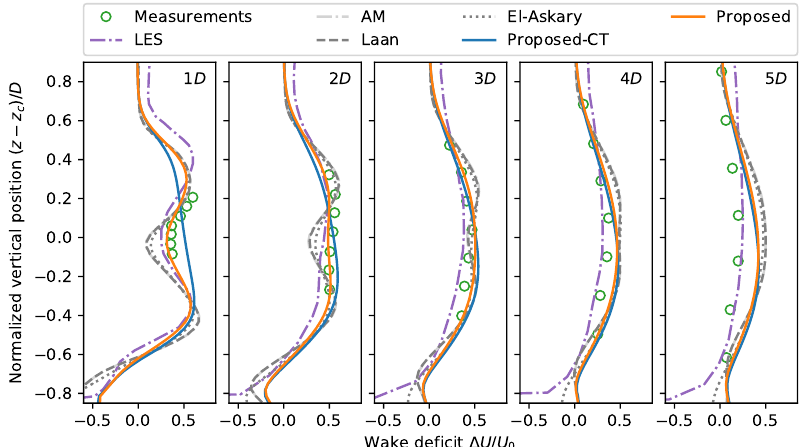
Figure 14. Same as Figure 13 but for vertical wake deficit